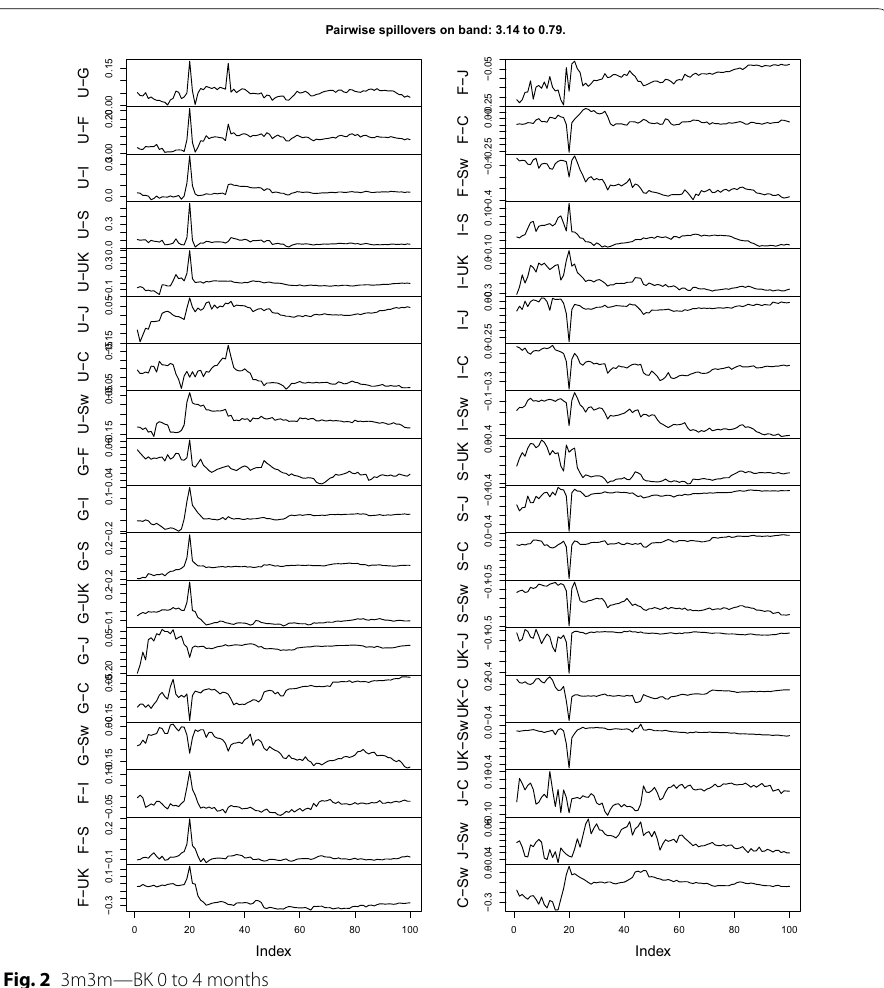
Fig. 2 3m3m—BK 0 to 4